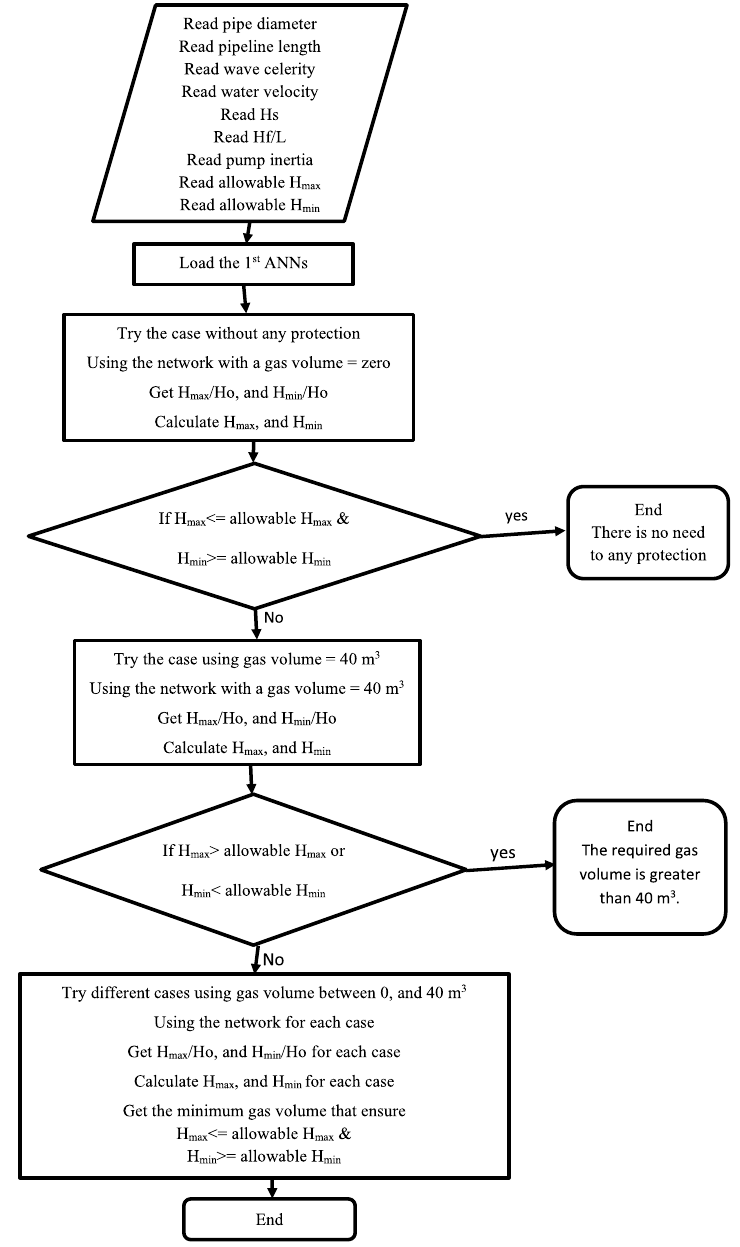
Fig. 9 Flow chart for the 1st